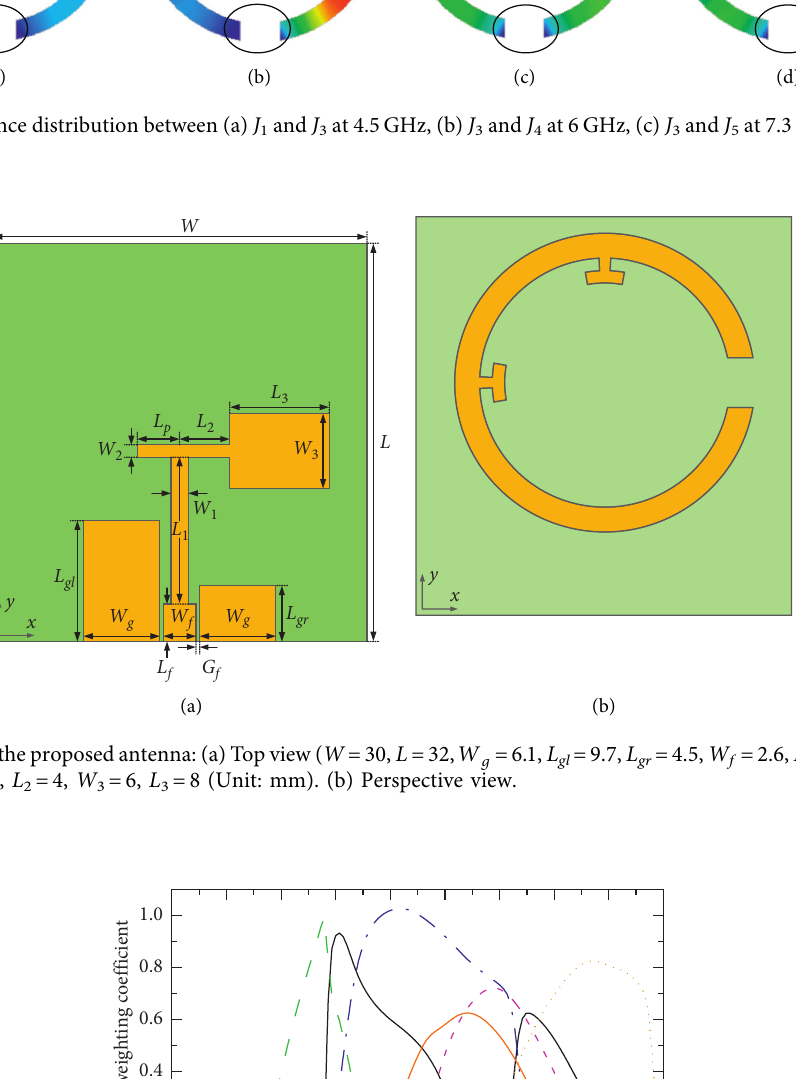
1 and J 3 at 4.5GHz, (b) J 3 and J 4 at 6 GHz, (c) J 3 and J 5 at 7.3 GHz, and (d) J 4 and J 6 at